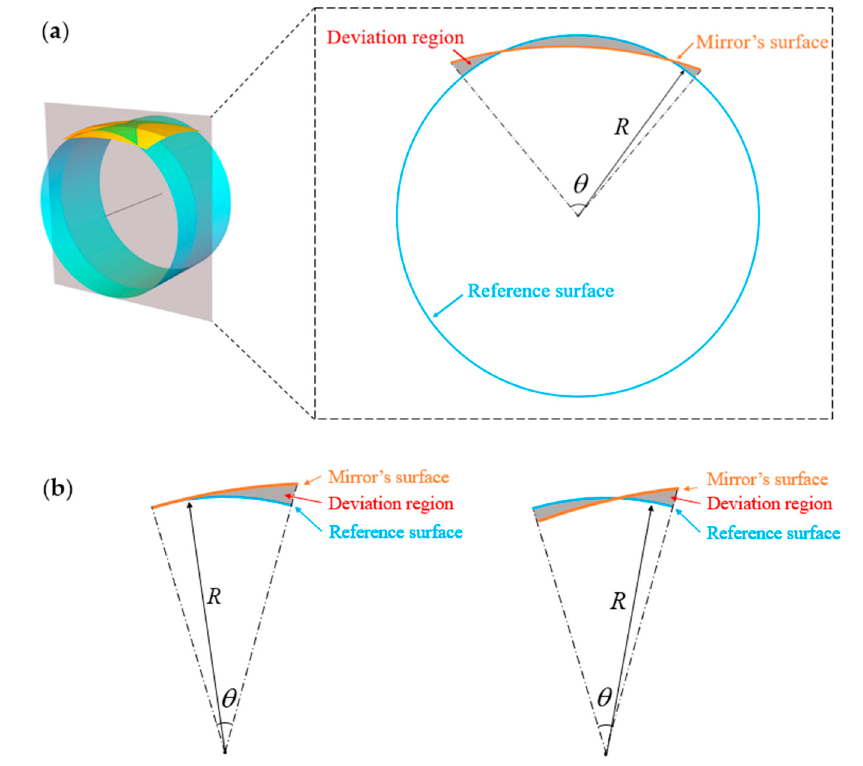
Figure 3. ( a ) The deviation region between the mirror’s surface and the reference surface in a cross-section. ( b ) Other possible positional relationships of the mirror and the reference surface.